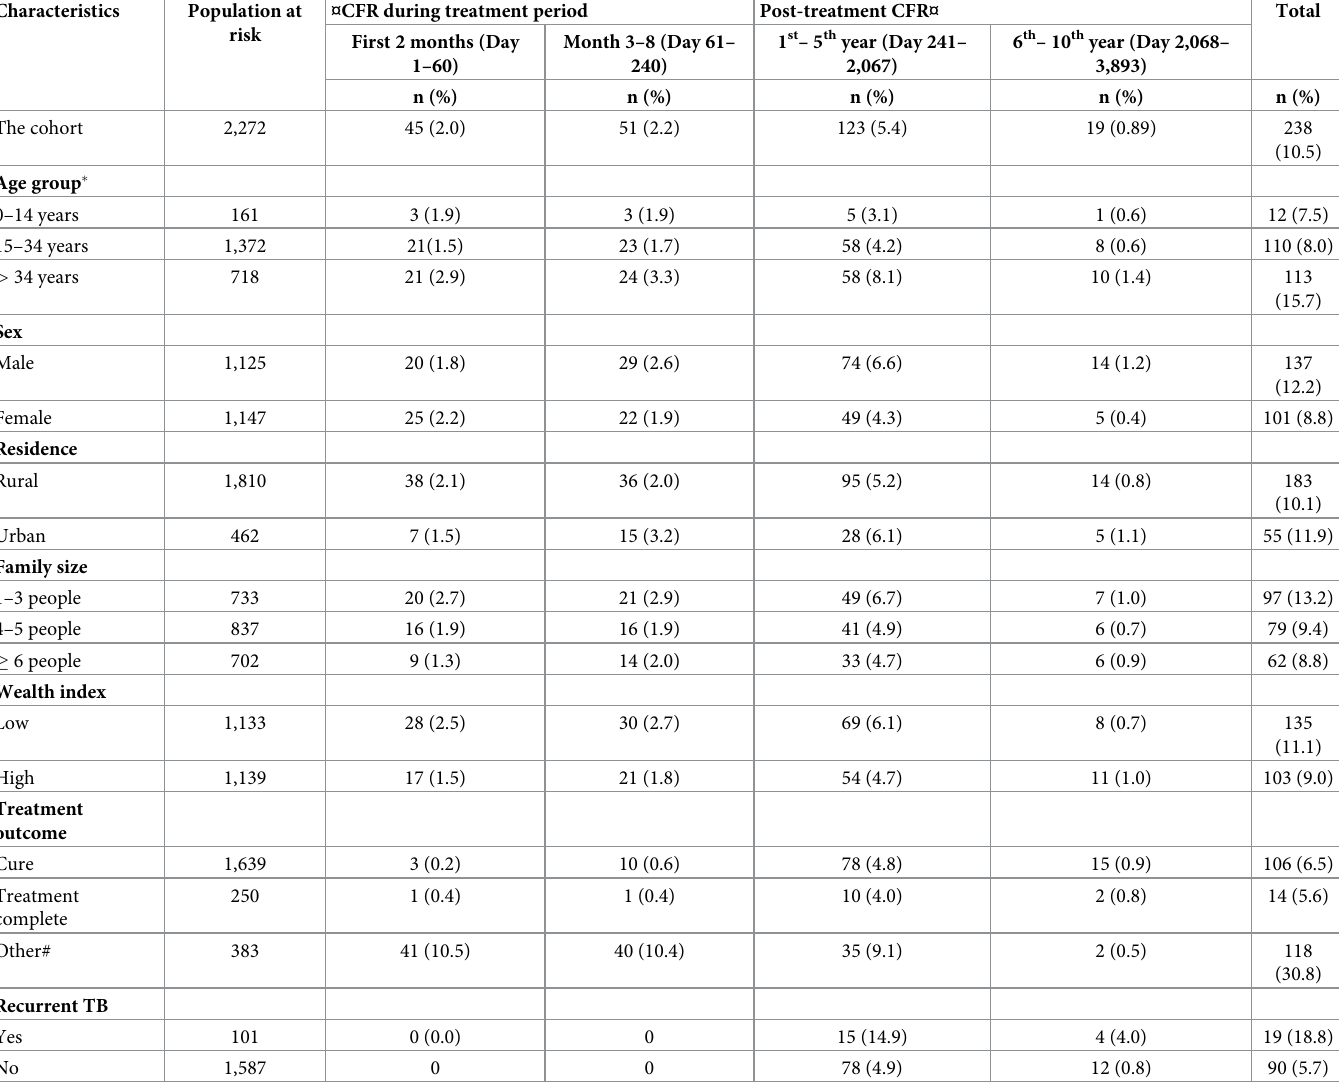
Table 5. Case fatality rate of TB patients during different periods of follow-up in Dale district, South Ethiopia.